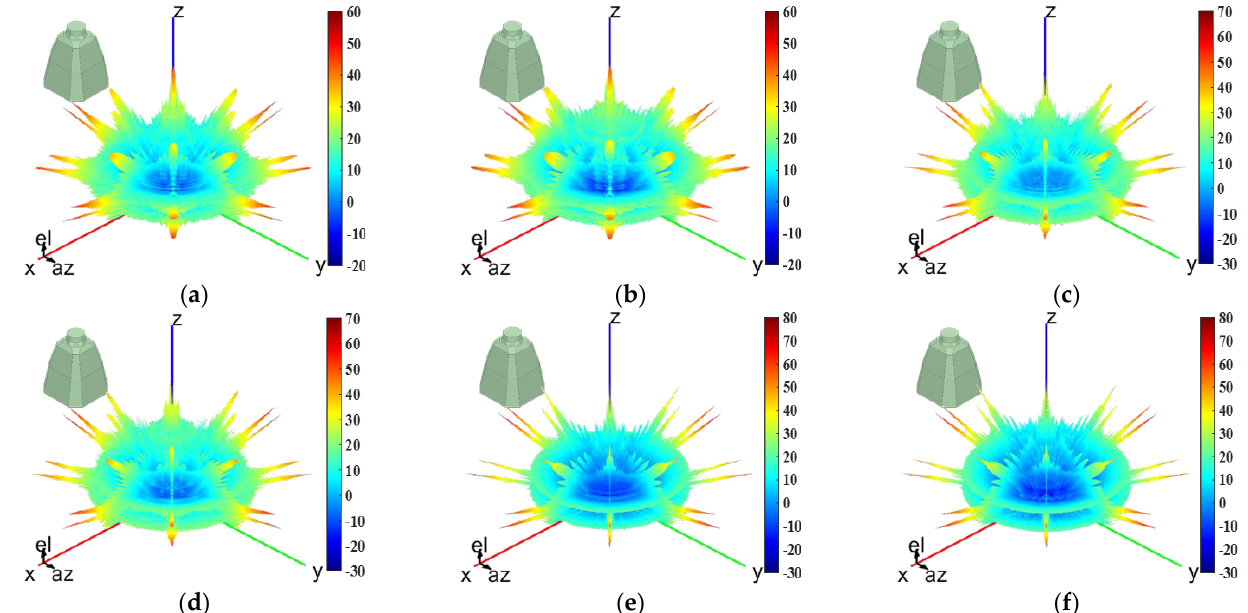
Figure 3. Dimension of the integrated mast. ( a ) initial mast, ( b ) optimized mast.